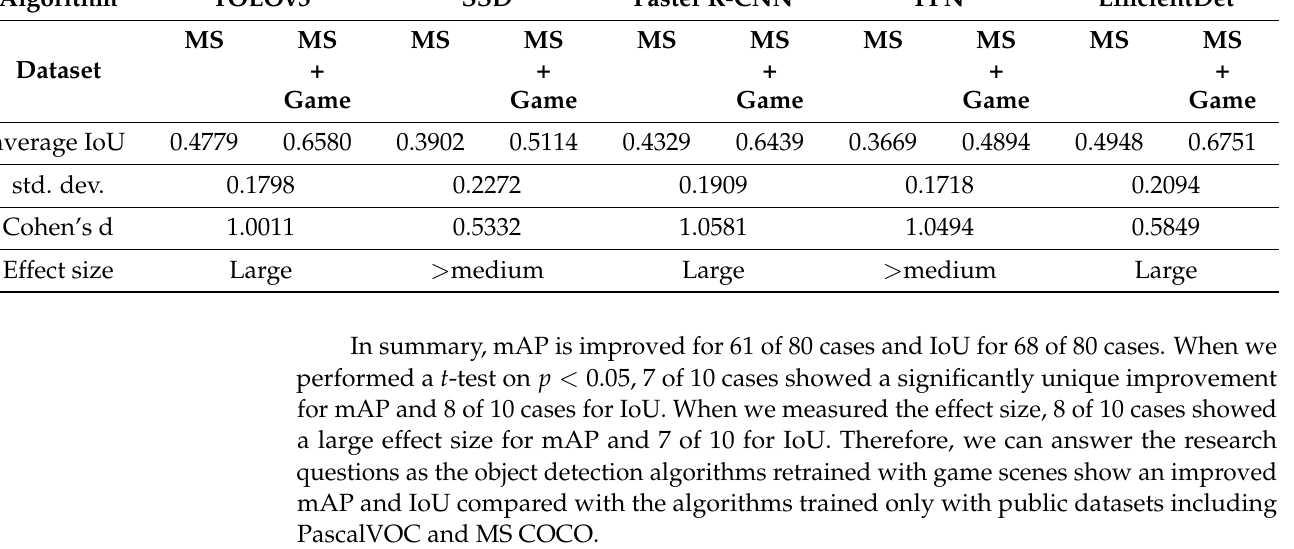
Table 15. Cohen’s d values for IoUs from four object detection algorithms. We compared the algorithms trained by MS COCO and retrained by MS COCO with game scenes. Note that MS COCO is abbreviated as MS in the table.